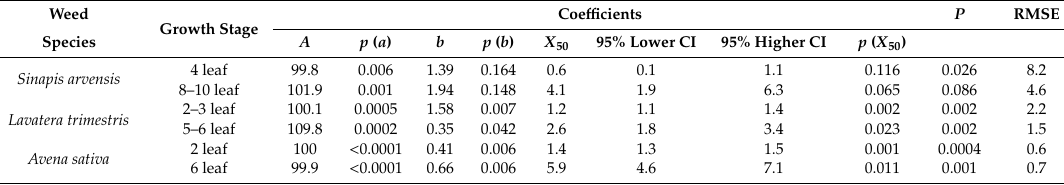
Table 5. Equation coe ffi cient of the three-parameter log-logistic regression 1 between propane dose (kg propane km − 1 ) and dry weight (% of non-treated control), with 95% confidence interval (CI) of the X 50 coe ffi cient and the regression computed p -values, probability ( p ), and root mean square error (RMSE)